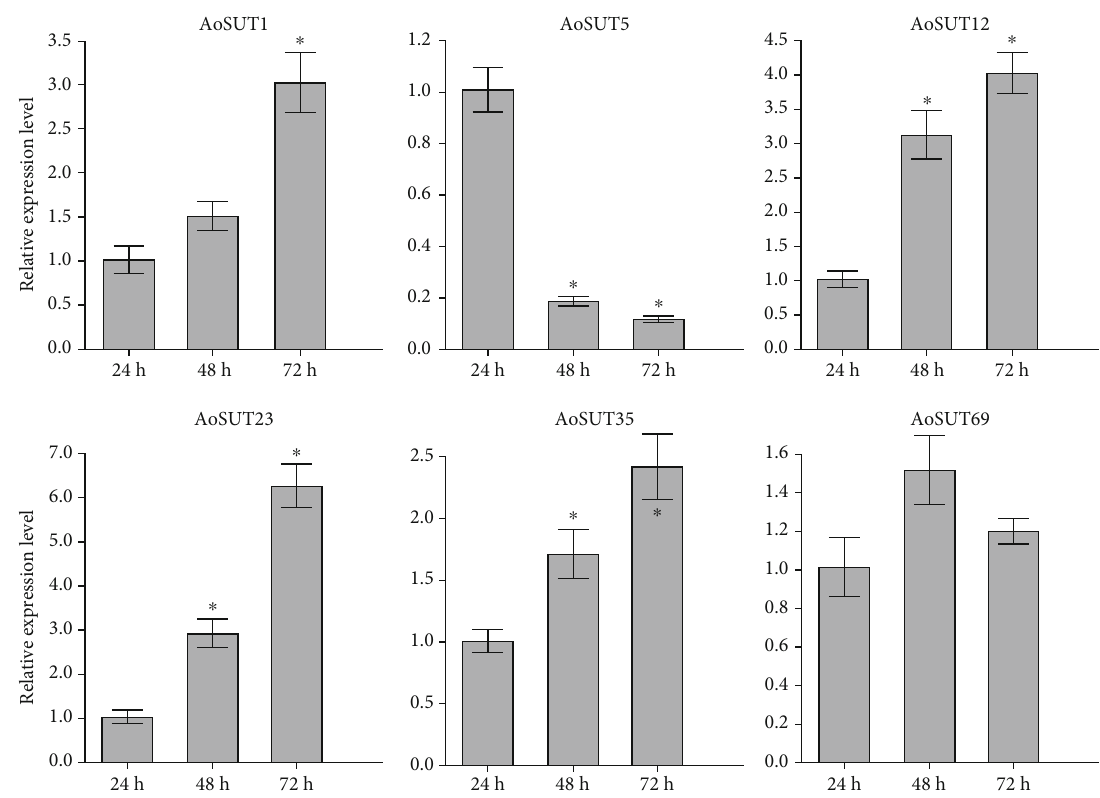
Figure 5: Expression pro fi les of six selected AoSUT genes at di ff erent stages of development determined by qRT-PCR. The bars represent the average ( ± SE) of biological repeats. Asterisks indicate statistical di ff erence between groups (Student ’ s t test): ∗ p < 0 : 05